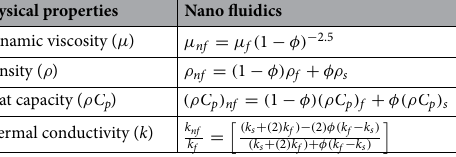
Table 1. Thermal–physical features of Oldroyd-B